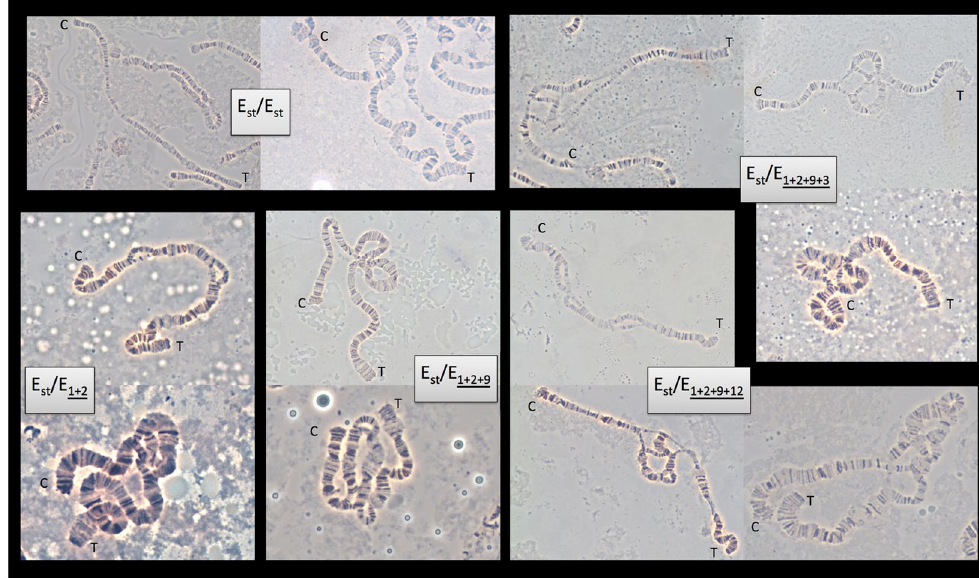
Figure 1. Micrographs of polytene chromosomes corresponding to homokaryotypic and heterokaryotypic individuals for E chromosome